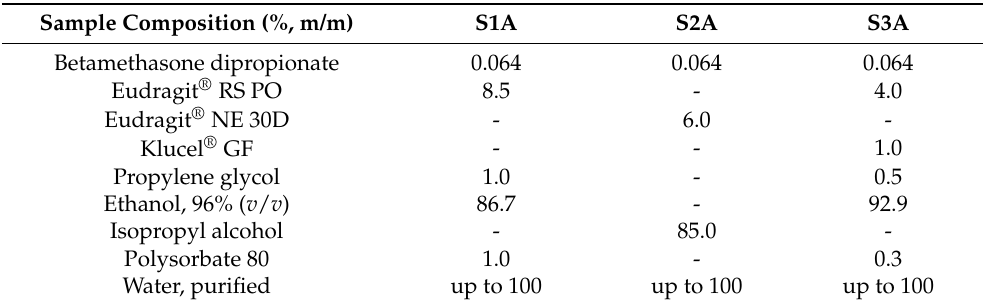
Table 1. Composition of the selected in situ film-forming formulations loaded with the model active pharmaceutical ingredient, BDP.